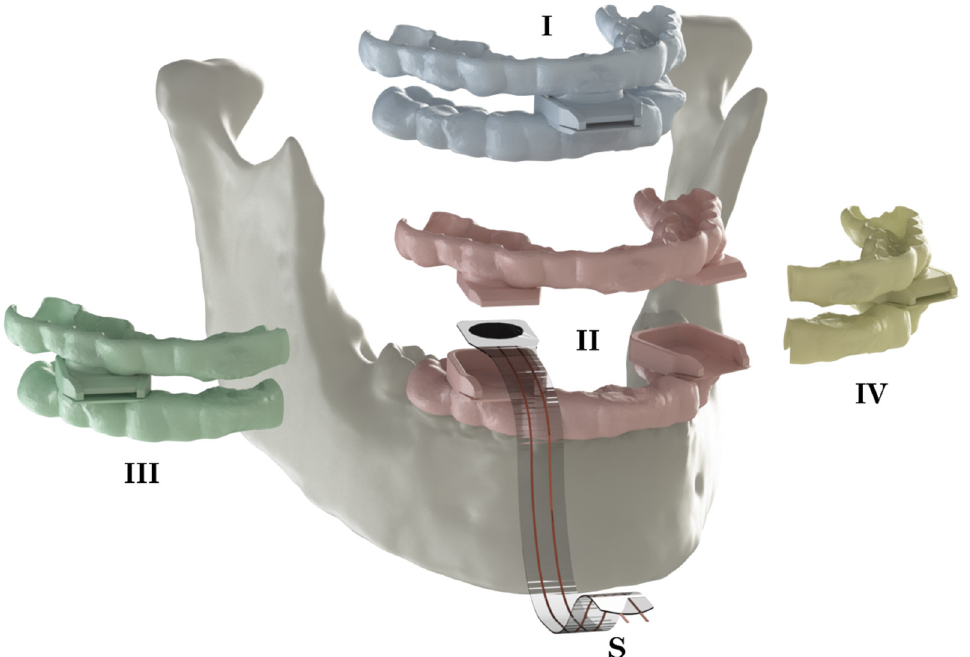
Figure 2. An overview of the used set-up including the bite sensor (S) and corresponding sets of upper and lower splints. The violet pair (I) of splints was used for incisal bite force measurements, the red pair (II) for bilateral premolar measurements, and the green (III) and yellow (IV) pairs for unilateral measurements of the right and left side of the premolars, respectively.